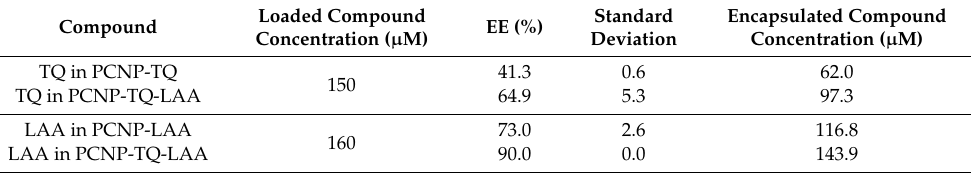
Table 4. The concentration of TQ and LAA loaded and encapsulated in PCNP samples.